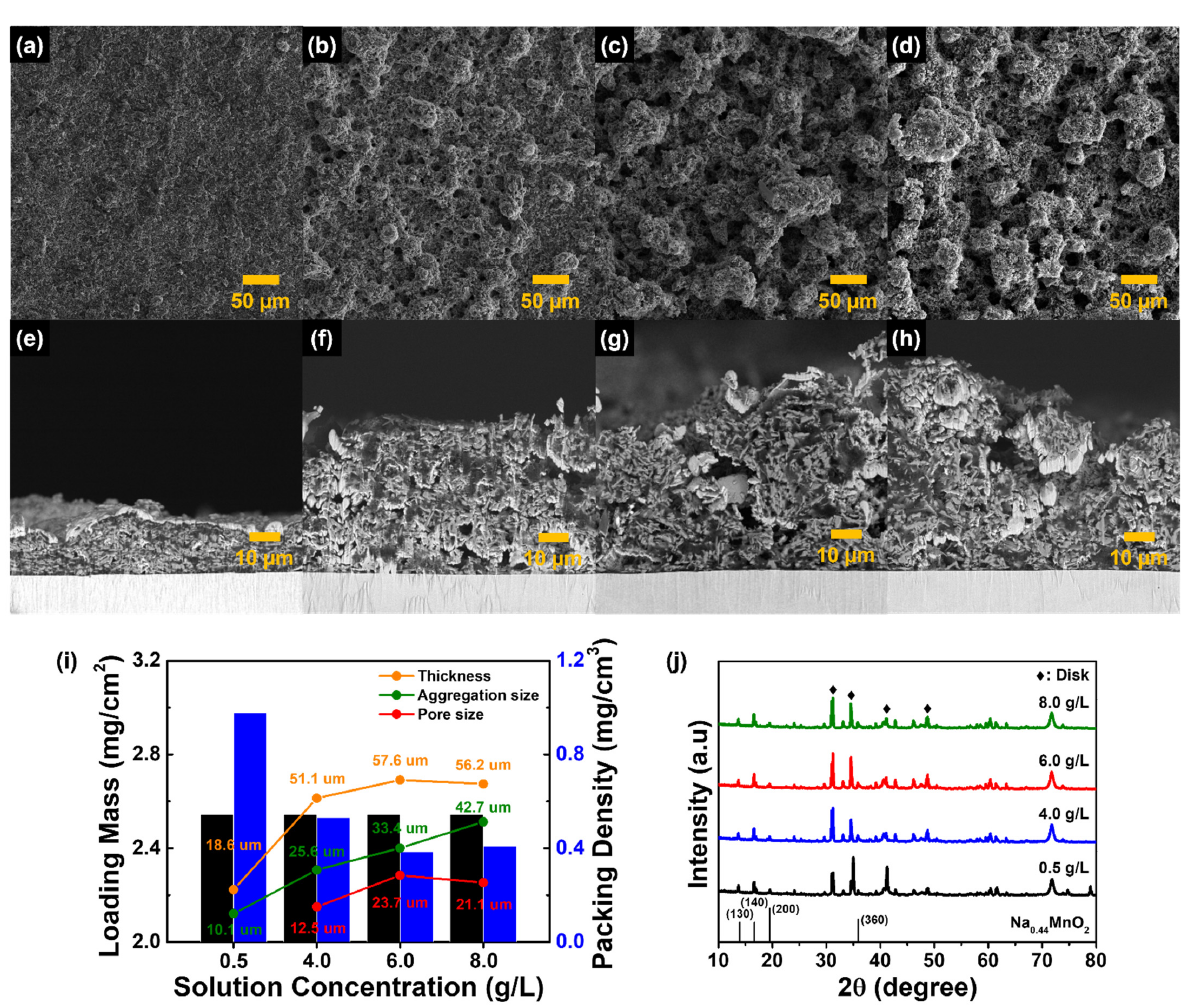
Figure 1. ( a – d ) Surface ‐ view and ( e – h ) cross ‐ section SEM images of the Na 0.44 MnO 2 electrodes with increasing solution concentrations from 0.5 to 8.0 g/L fabricated by the one ‐ pot spraying process, ( i ) comparison of the electrode factors (loading mass (black histogram), packing density (blue histo ‐ gram), thickness, aggregation size, and pore size) with the varying solution concentrations, and ( j ) the XRD curves of all the electrodes.